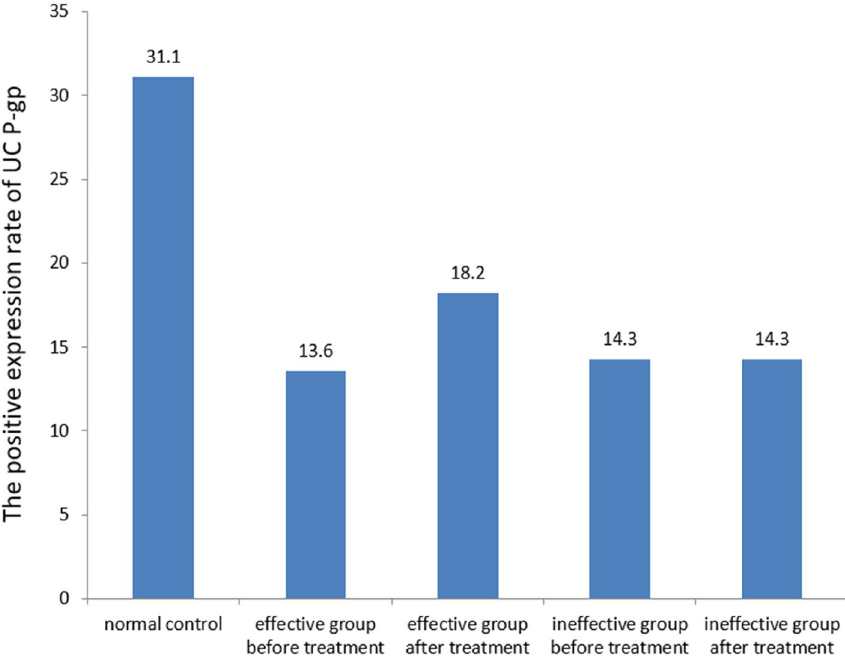
Figure 3. Effect of aminosalicylic acid drugs on P-gp expression in ulcerative colitis. Calculated from the data in Table 4, shown as mean values. Significant differences between groups are detailed in Table 4.